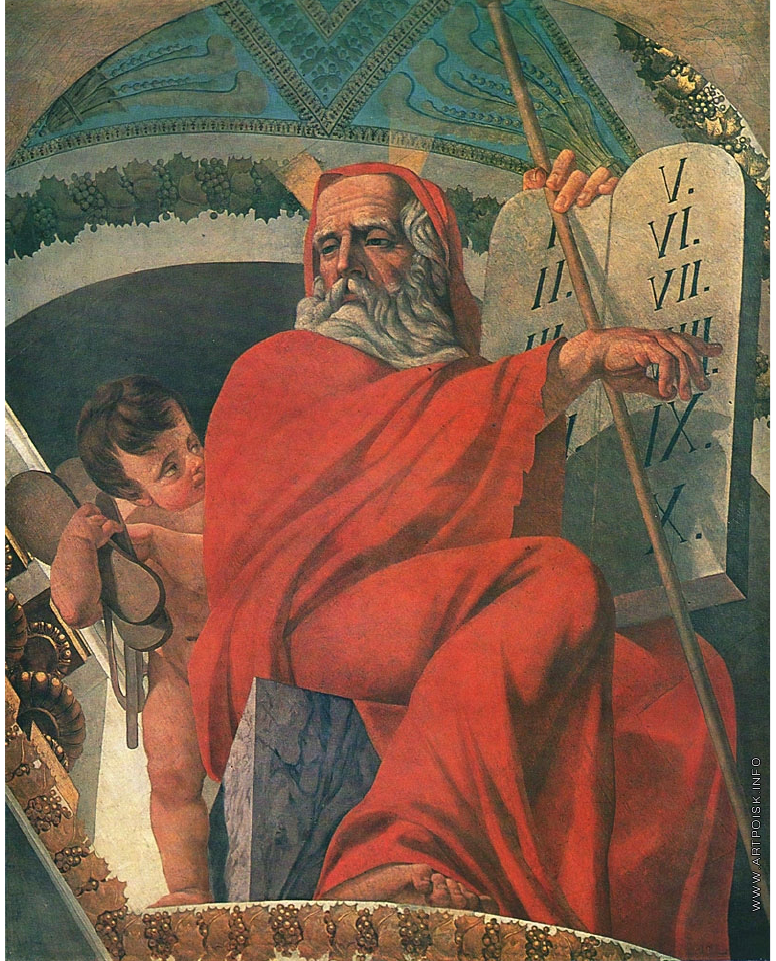
Figure 9. Vasilii Shebuev. Moses with Tablets of the Commandments , 1821–23. Sukachov Irkutsk Regional Museum of Art.